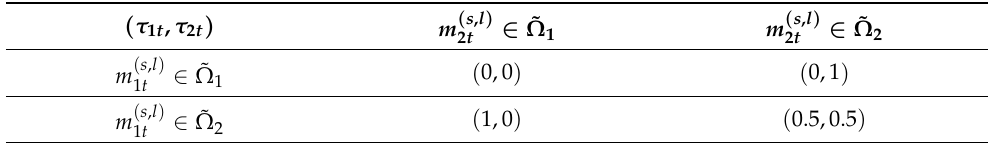
Table 1. MA strategy T t = ( τ 1 t , τ 2 t ) (cid:62) for a two-asset